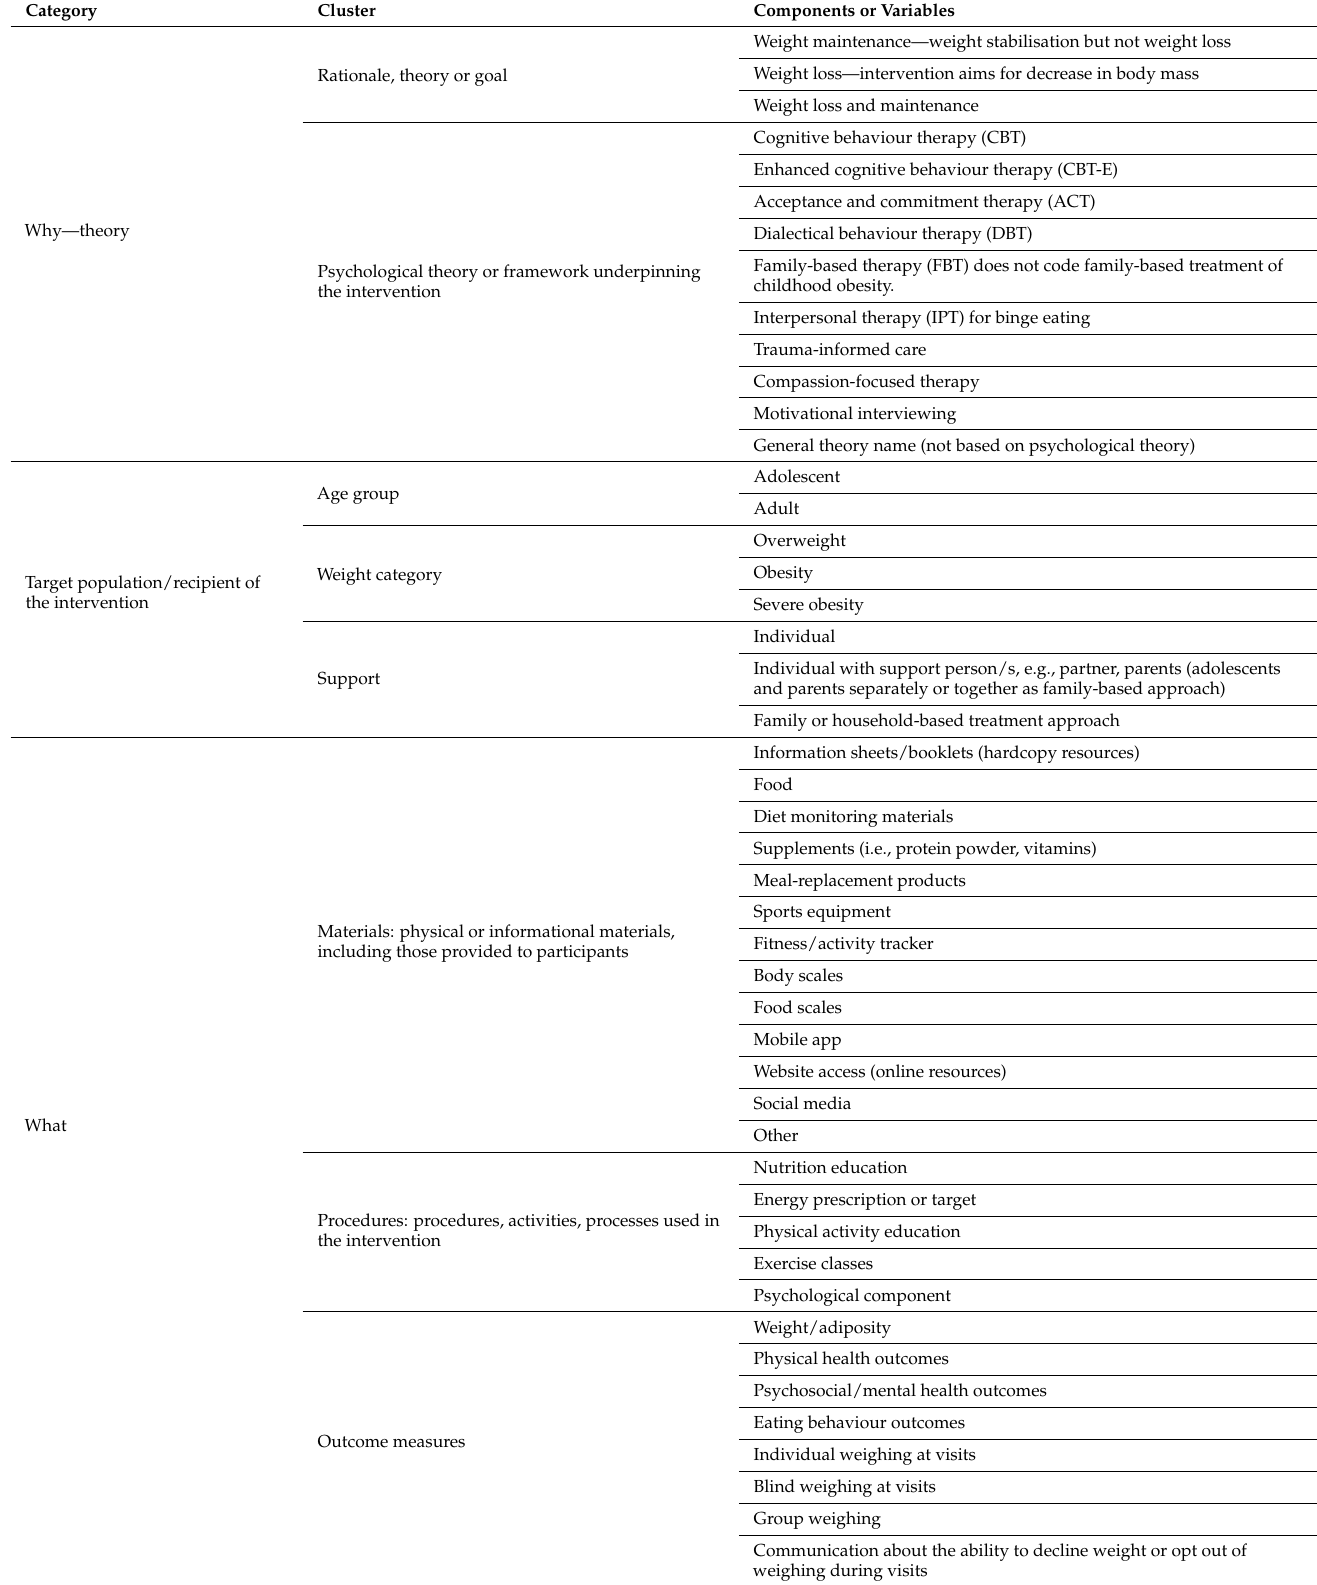
Table 2. Codebook of delivery features a